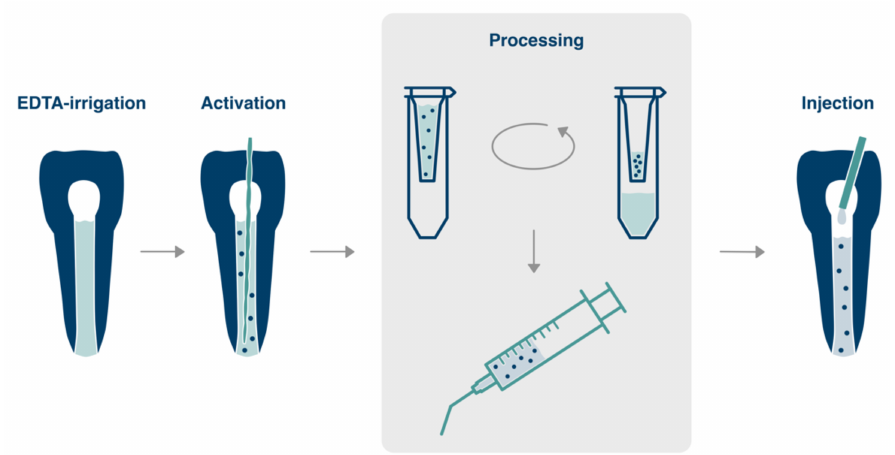
Figure 1. Envisioned clinical procedure. After root canal preparation and disinfection, EDTA is used to remove the smear layer. After refreshment of EDTA, the solution is activated by ultrasound, which releases growth and differentiation factors from the dentin surface. The solution is removed from the canal, and proteins are concentrated via a chairside centrifugation step. A hydrogel biomaterial, e.g., a fibrin-based scaffold, is mixed with concentrated dentin matrix proteins and injected back into the root canal in contact with the periapical